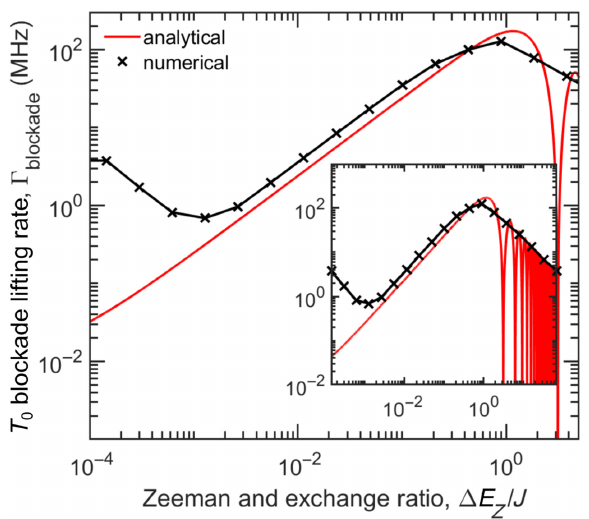
FIG. 4. Validity limits of the analytical perturbative expres- sion. Comparing (cid:4) blockade obtained by the analytical expression in Eq. (A13) to the numerical calculations for different values of / J , where the inset shows this on a larger range. The analyti- (cid:3) E Z cal approximation is shown to be valid for ratios (cid:3) E Z / J between 10 − 2 and 2. The upper limit is inherent to the perturbative nature of the analysis, while the lower limit relates to the regime where the nonunitary evolution can no longer be treated by the con- ventional SW method and must be incorporated explicitly in the